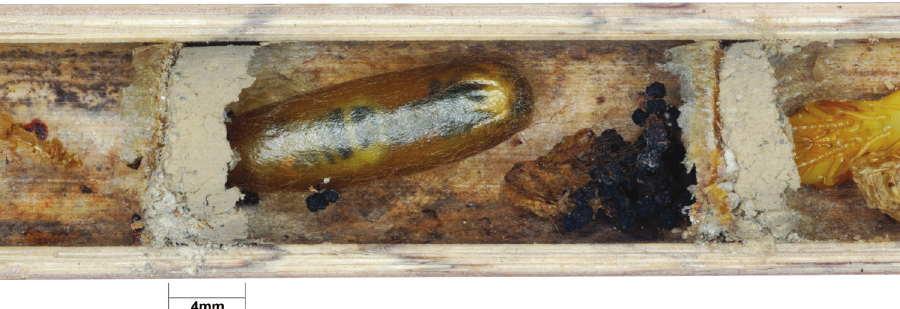
Figure 6. Cell 4 of trap SLT-025.A4 showing the coloration of the pupa inside the